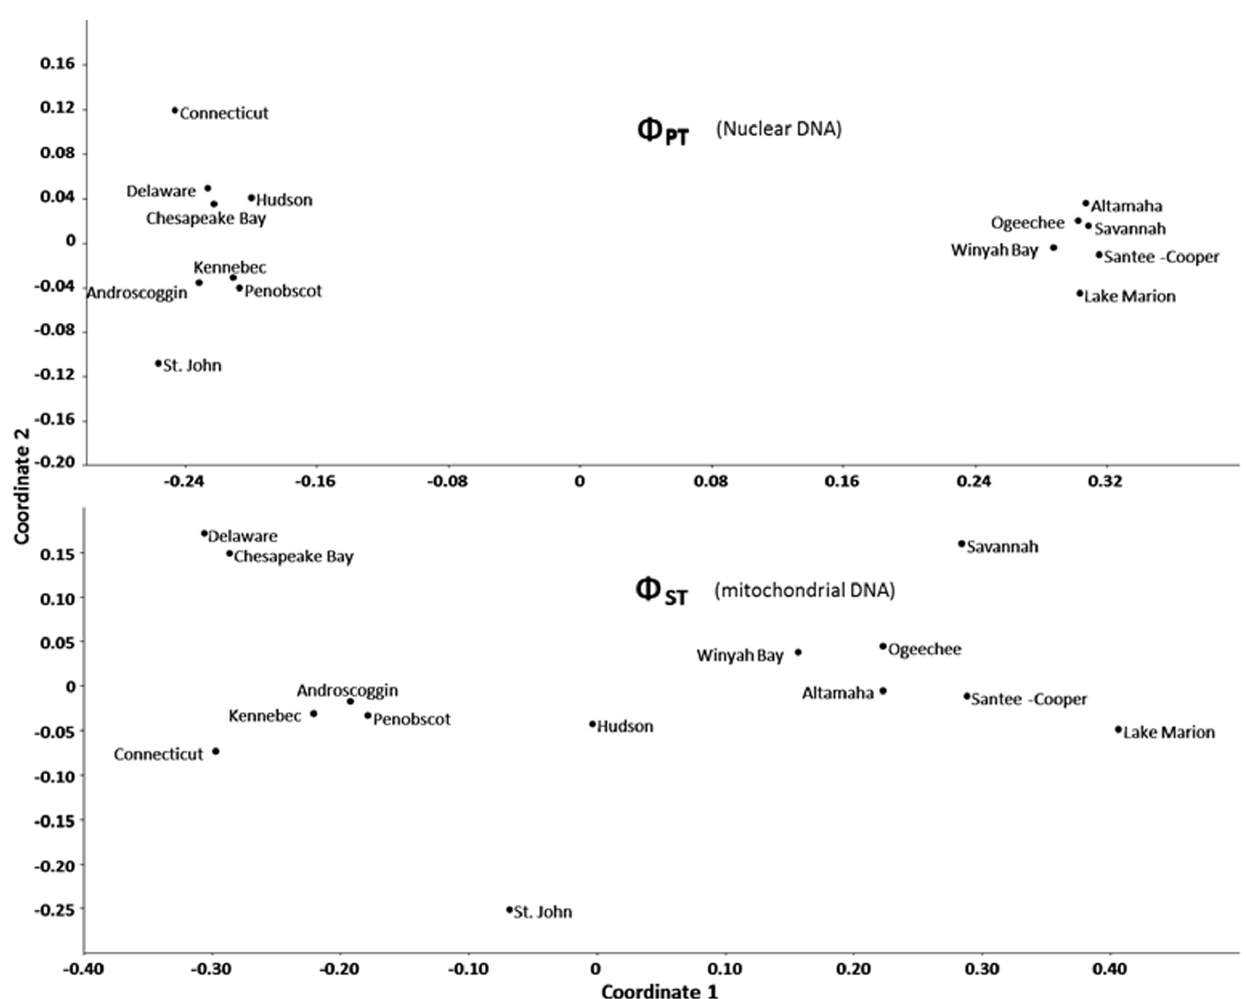
Figure 5. Results of independent multidimensional scaling analyses of pair-wise a) W PT (nuclear DNA; Table 4, this study) and b) W ST (mitochondrial DNA; Table 5 of Wirgin et al. [30] ) matrices for 14 Acipenserbrevirostrum collections that are in common between the two studies.